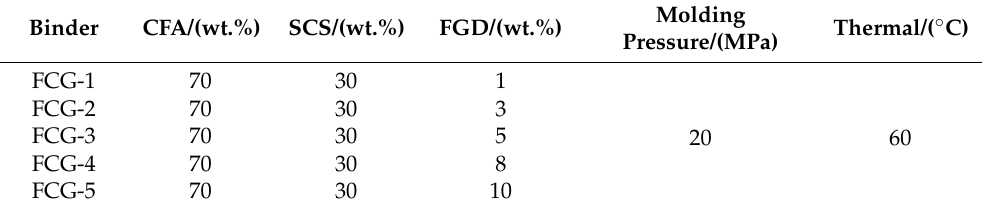
Table 2. Mixture proportions of paste